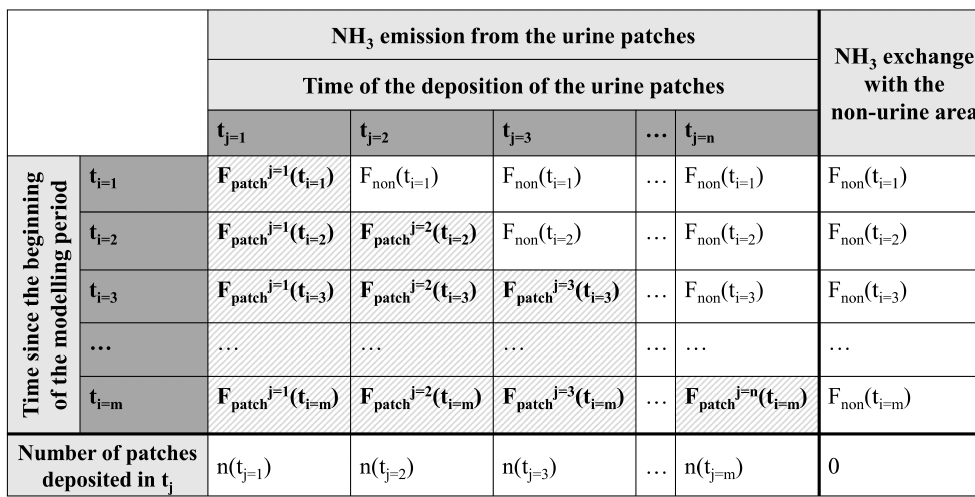
( t i ) stands for patch